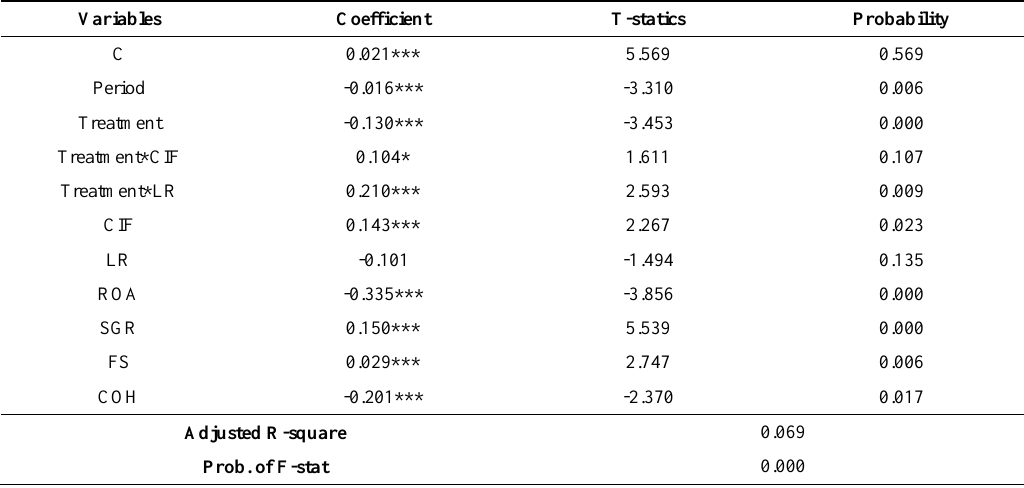
Table 7. Location Sensitivity and Corporate